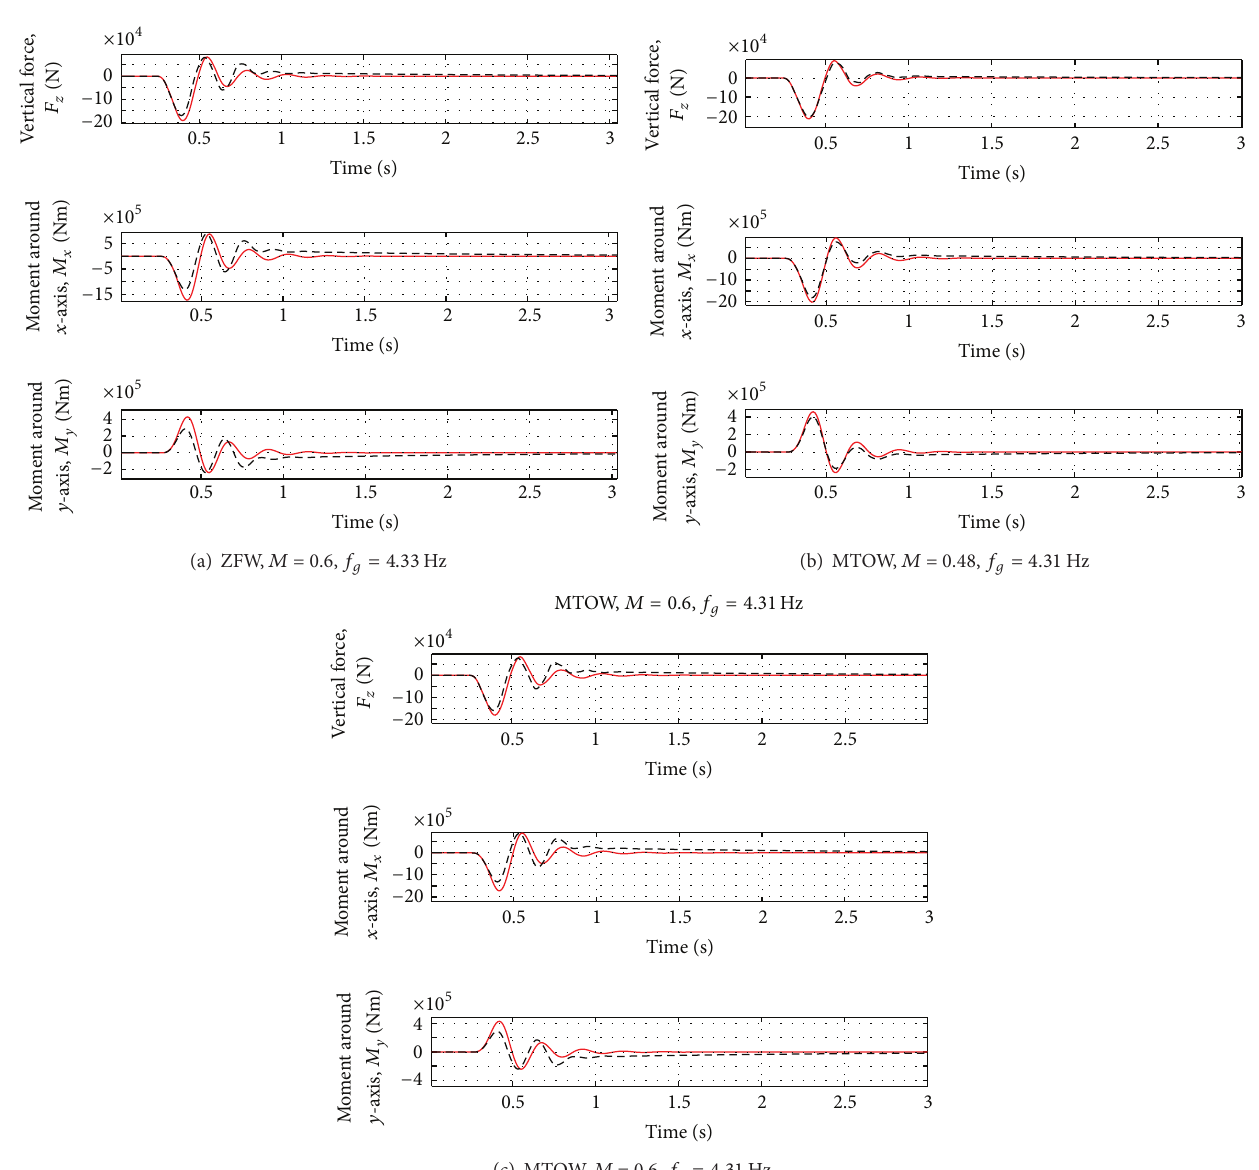
(c) MTOW, 𝑀 = 0.6, 𝑓 𝑔 = 4.31 Hz Figure 8: Wing loads for all the cases in Table 3. Red solid line: open loop. Black dotted line: closed